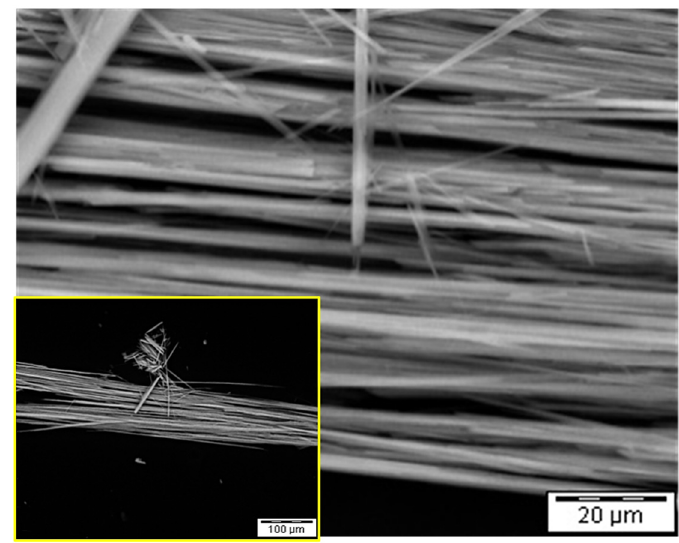
Figure 15. α -HH out of DH after 240 min of hydration.